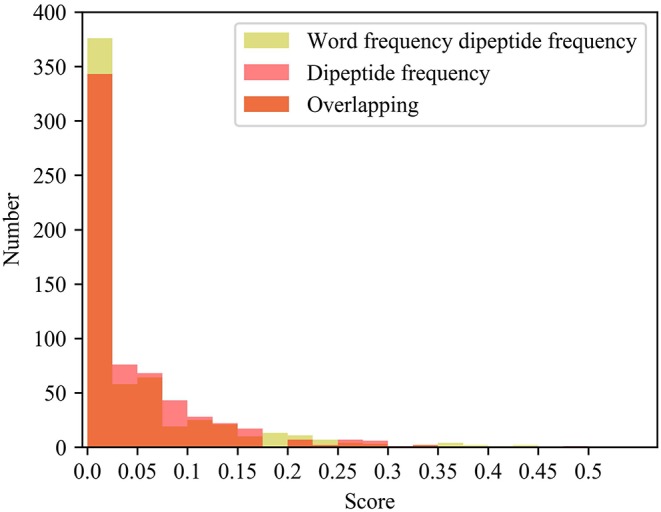
Histogram of frequency distribution. Yellow represents the histogram of the frequency distribution of the word frequency dipeptide, red represents the histogram of the frequency distribution of the word frequency dipeptide, and orange represents the overlap between the two.